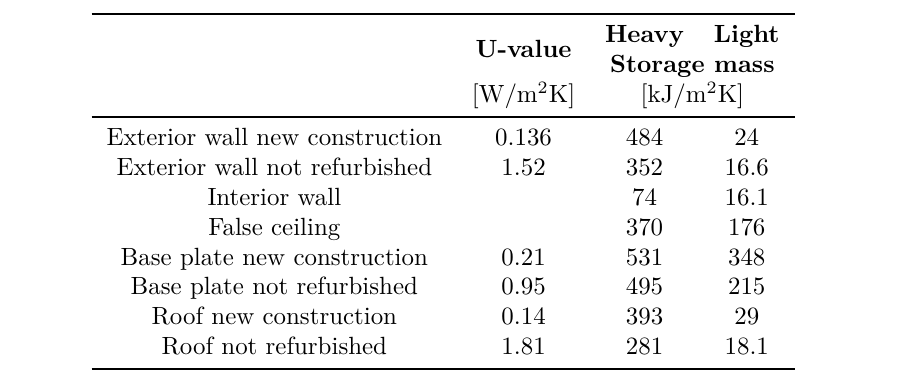
Table 2. Characteristic values of the building